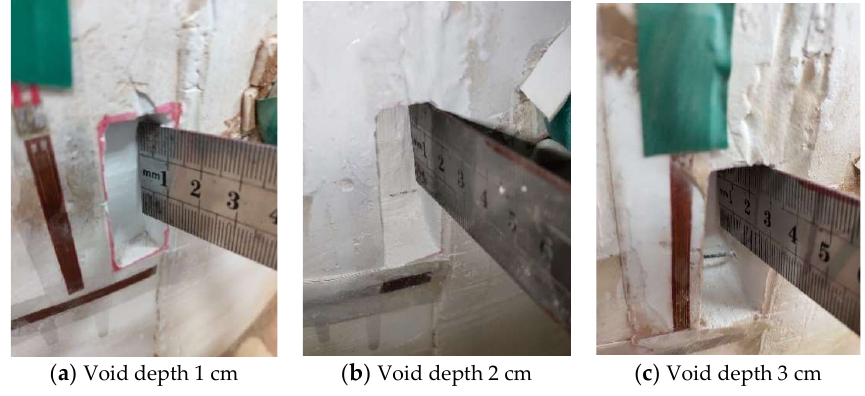
Figure 7. Vault void at different depths.